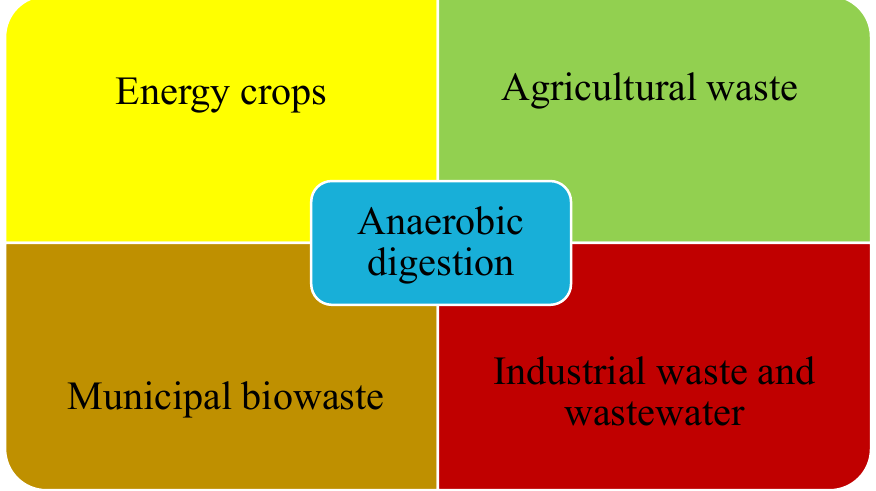
Figure 1. Sources of suitable substrates for anaerobic digestion [14] .